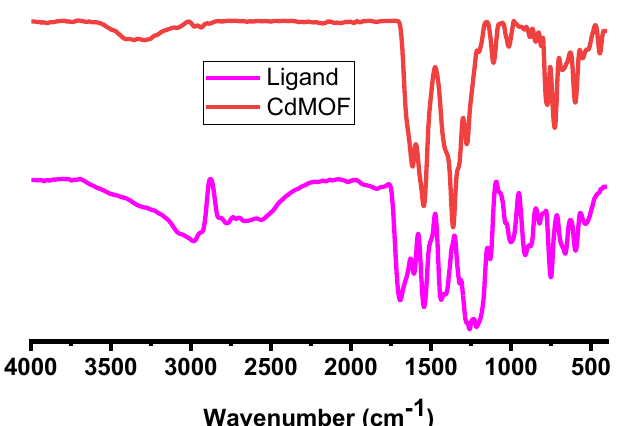
Figure 1. FT − IR spectra of ligand and as − synthesized CdMOF.